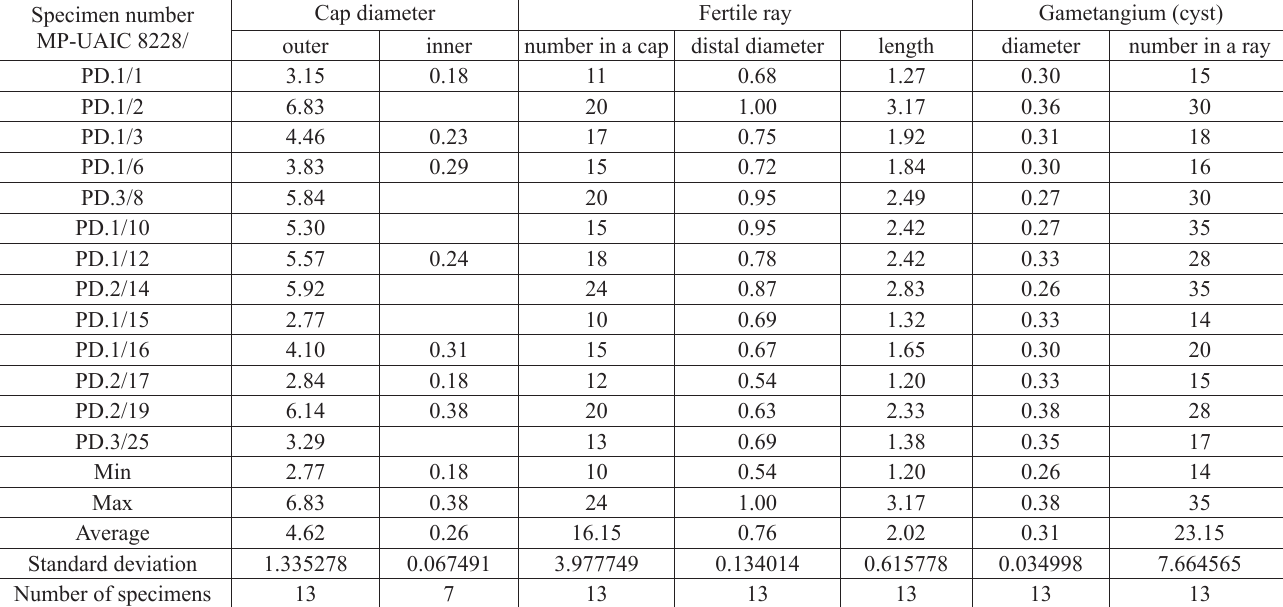
Table 1. Main biometrical parameters (in mm) of Acetabularia moldavica sp. nov.; gametangium (cyst) diameter with mineralized layer included. Specimen number MP-UAIC 8228/